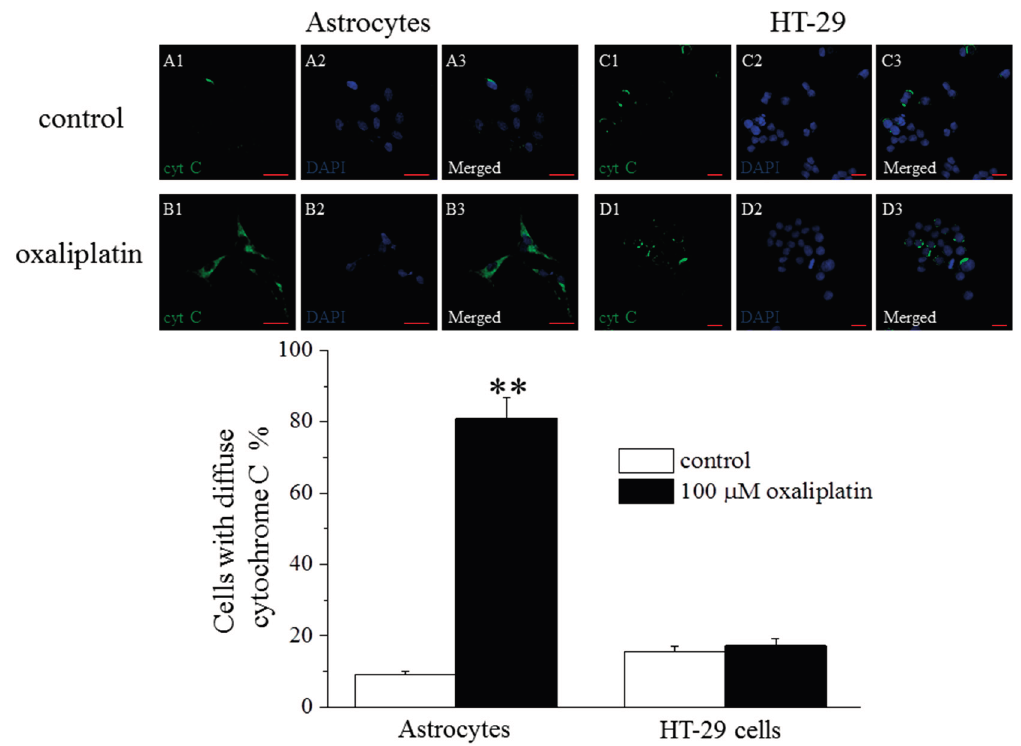
Figure 1. Cytosolic release of cytochrome C. Astrocytes (5 × 10 4 cells/slide) and HT-29 (5 × 10 4 cells/slide) were exposed to 100 μ M oxaliplatin for 8 h. Specimens were stained with anti-cytochrome C and a secondary antibody conjugated with Alexa Fluor 488 (green) and DAPI (blue) for nucleus visualization. ( A1 – A3 ) control astrocytes; ( B1 – B3 ) oxaliplatin-treated astrocytes; ( C1 – C3 ) control HT-29; ( D1 – D3 ) oxaliplatin-treated HT-29. Calibration: 20 µm. Bars represent the mean ± S.E.M of cells displaying a diffuse cytosolic distribution of cytochrome C as percentage of total analyzed cells. Cells were counted using the “cell counter” plugin of ImageJ 1.33, free-share image analysis software (ImageJ, NIH, Bethesda, MD, USA). At least three fields (40X 0.75NA objective) per slide and two slides